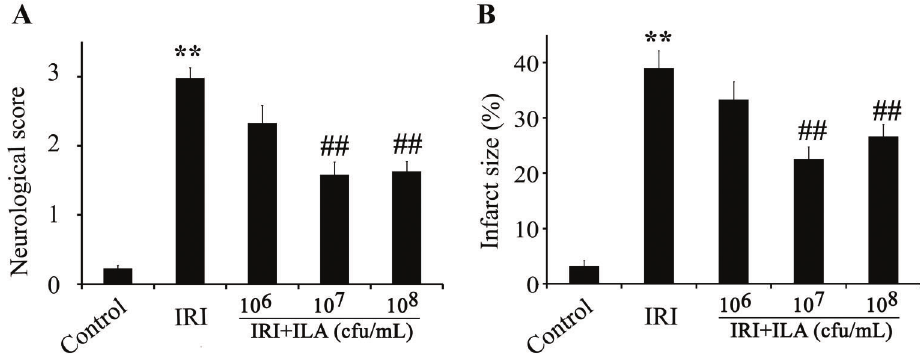
Figure 1. Effect of different concentrations of inactivated lactobacillus (ILA) on neurological de fi cit ( A ) and infarct size ( B ) after cerebral ischemia reperfusion injury (IRI) (n=4). Data are reported as means ± SD. **P o 0.01 vs control; ## P o 0.01 vs IRI (ANOVA, followed by Duncan ’ s multiple range